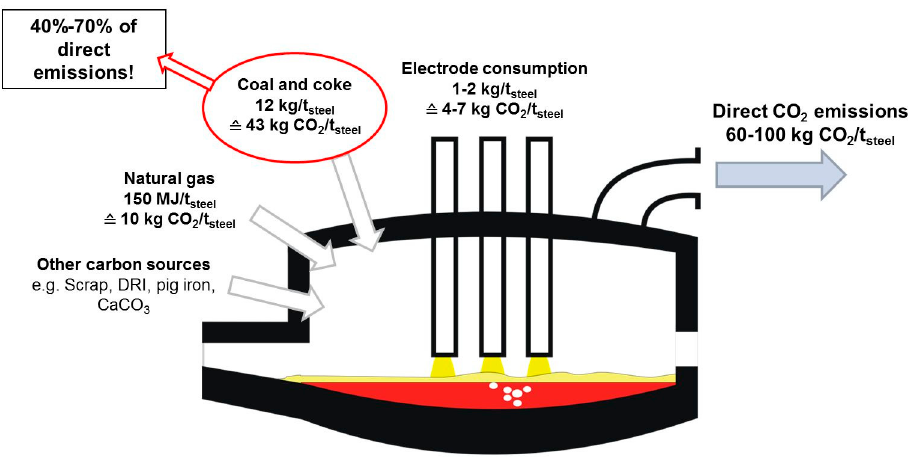
Figure 1. Direct CO 2 emissions of a typical EAF [22].